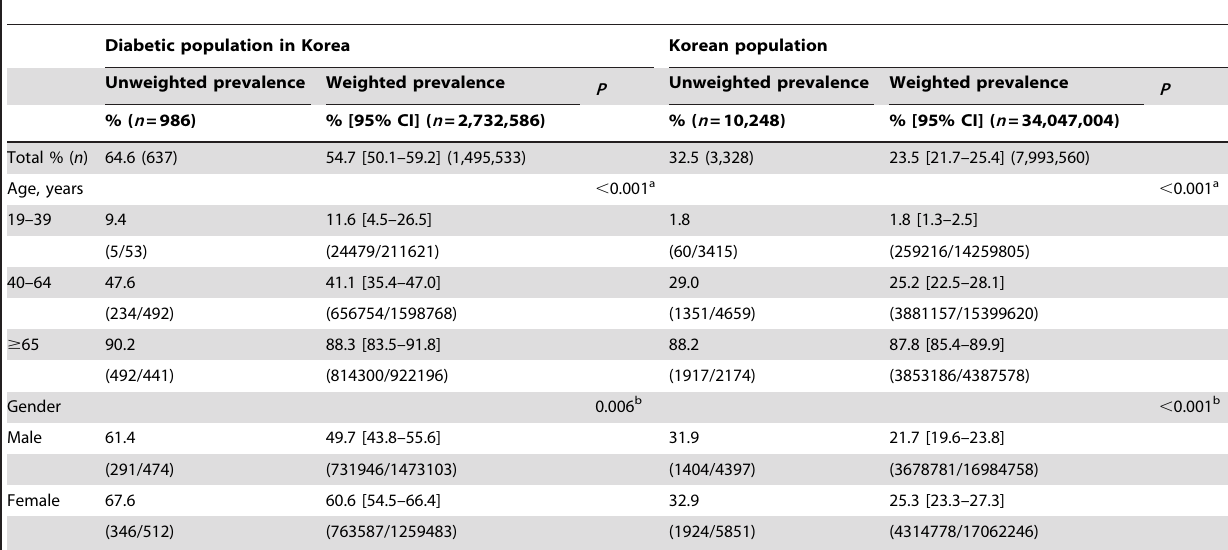
a P for difference of weighted prevalence among three age group. b P of weighted prevalence between each gender. doi:10.1371/journal.pone.0094189.t001 PLOS ONE |